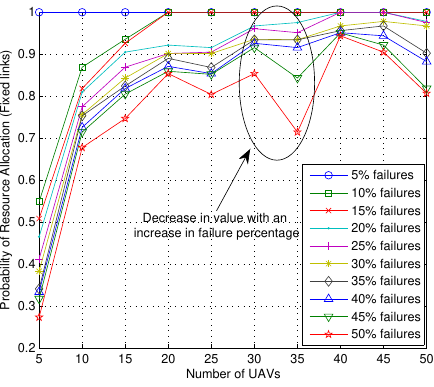
Figure 12. Probability of resource allocation with fixed link deployment vs. number of